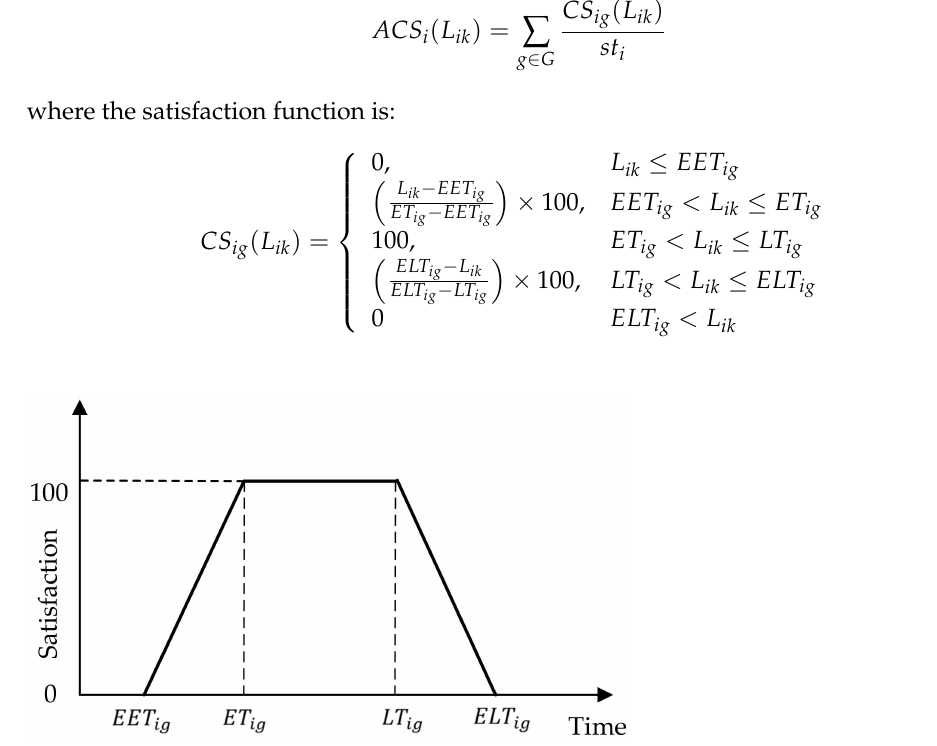
Figure 1. Customer satisfaction